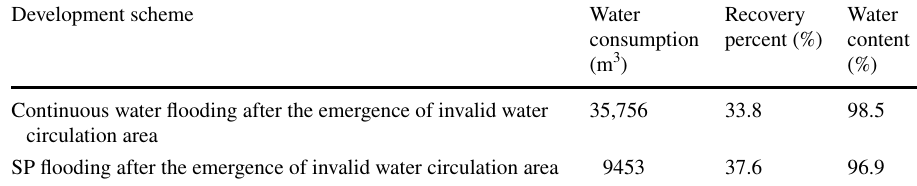
Table 1 Comparison of development effect of continuous water flooding and SP flooding after the formation of ineffective water circulation